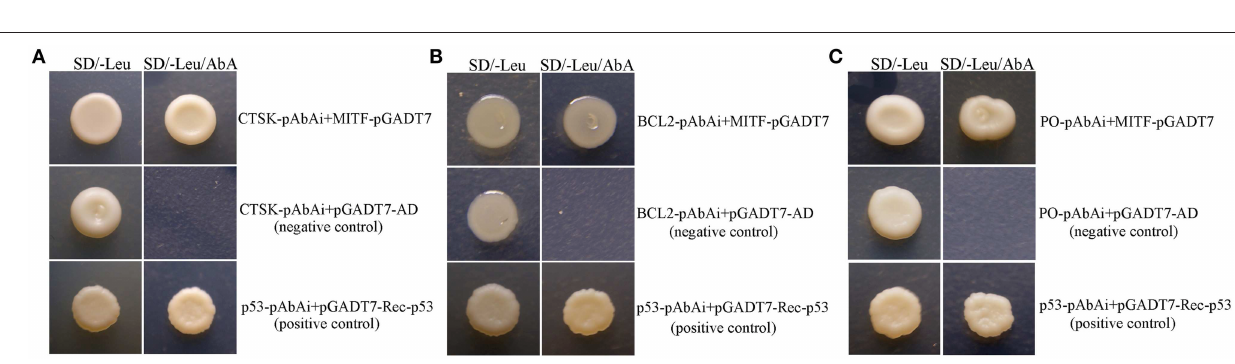
FIGURE 3 | Interaction between MpMITF protein and the MpPO/MpCTSK/MpBCL-2 promoters. (A) The MpMITF protein synthesized by in vitro transcription and shown by Western blot. (B–D) Incubation of biotin-labeled MpPO/MpCTSK/MpBCL-2 promoter probes with the MITF protein formed a strong shifted band (line 2) compared to labeled MpPO/MpCTSK/MpBCL-2 promoter probes alone (line 1). Binding was prevented by the addition of excess unlabelled competitor DNA (line 3). The shifted band and free probe are marked with the arrowheads.